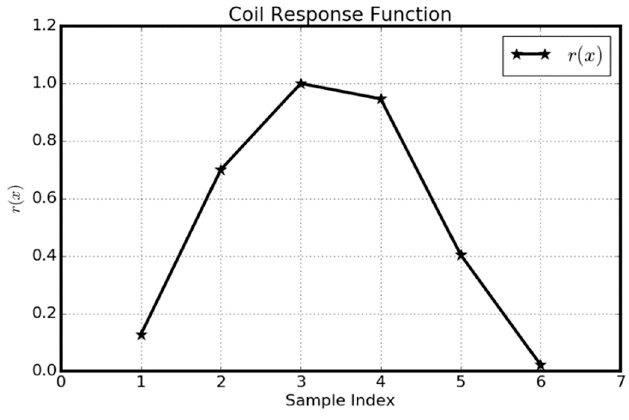
Figure 5. The digitized response function of the coil.